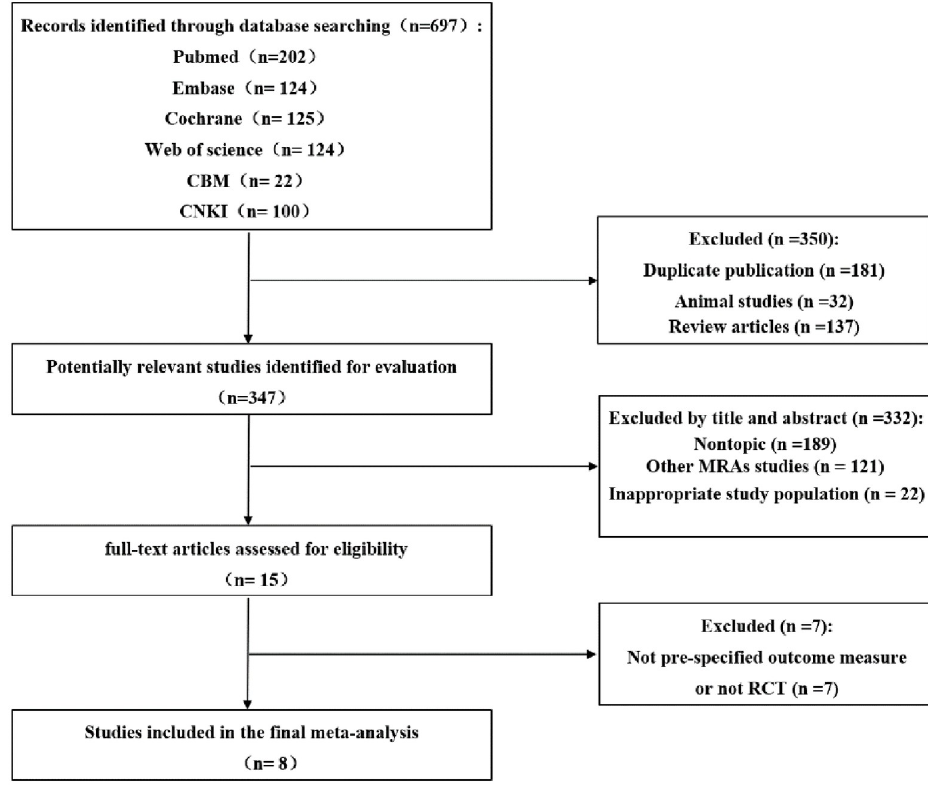
Fig 1. Flow chart of the article search